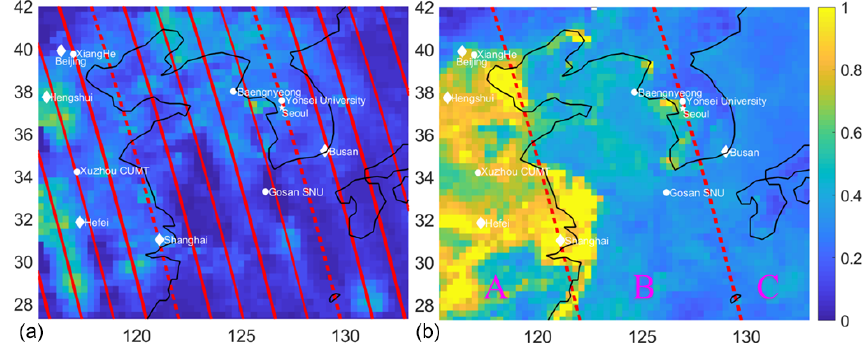
Figure 5. Seasonal distribution of aerosol optical depth (AOD) at 26–41 ◦ N, 117–132 ◦ E, for March to May 2015 based on RXS-expand (a) and MODIS (b) . Lines mark CALIPSO ground tracks. Dotted tracks are used as the boundaries for the analysis of aerosol subtypes in Fig. 6. White circles mark AERONET sites. Star marks the AD-Net site at Seoul. Diamonds mark some major cities.